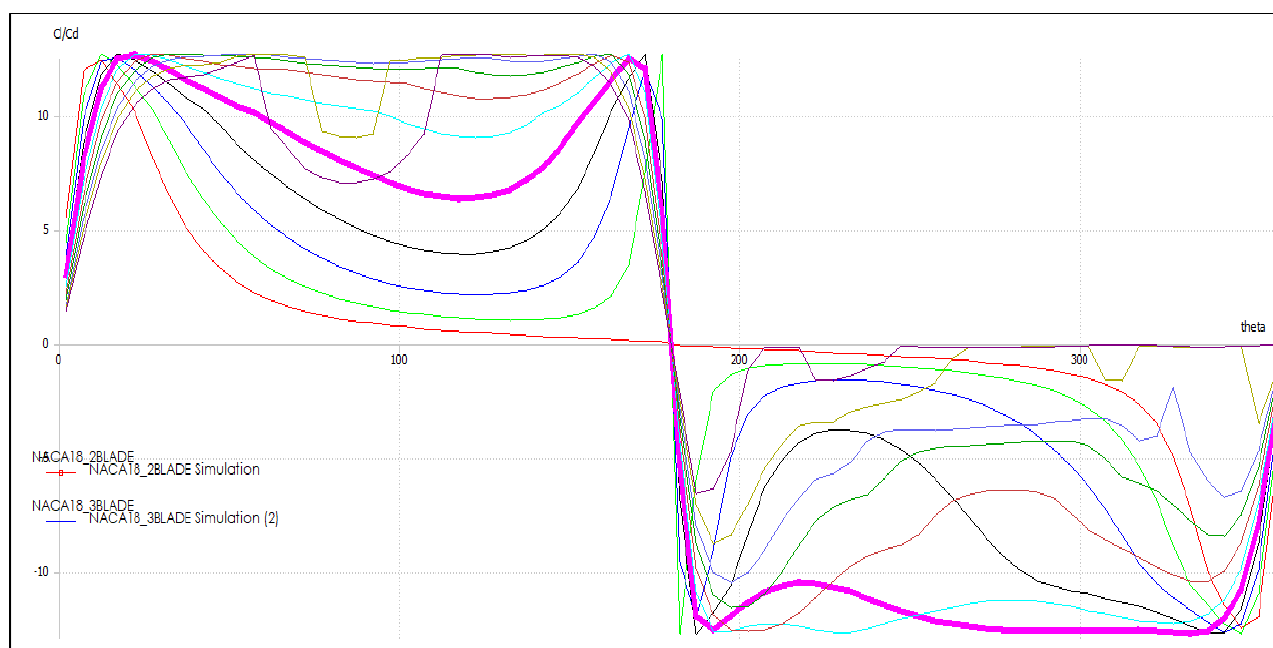
Figure 30. Cl/Cd vs theta plot of mid-section for TSR